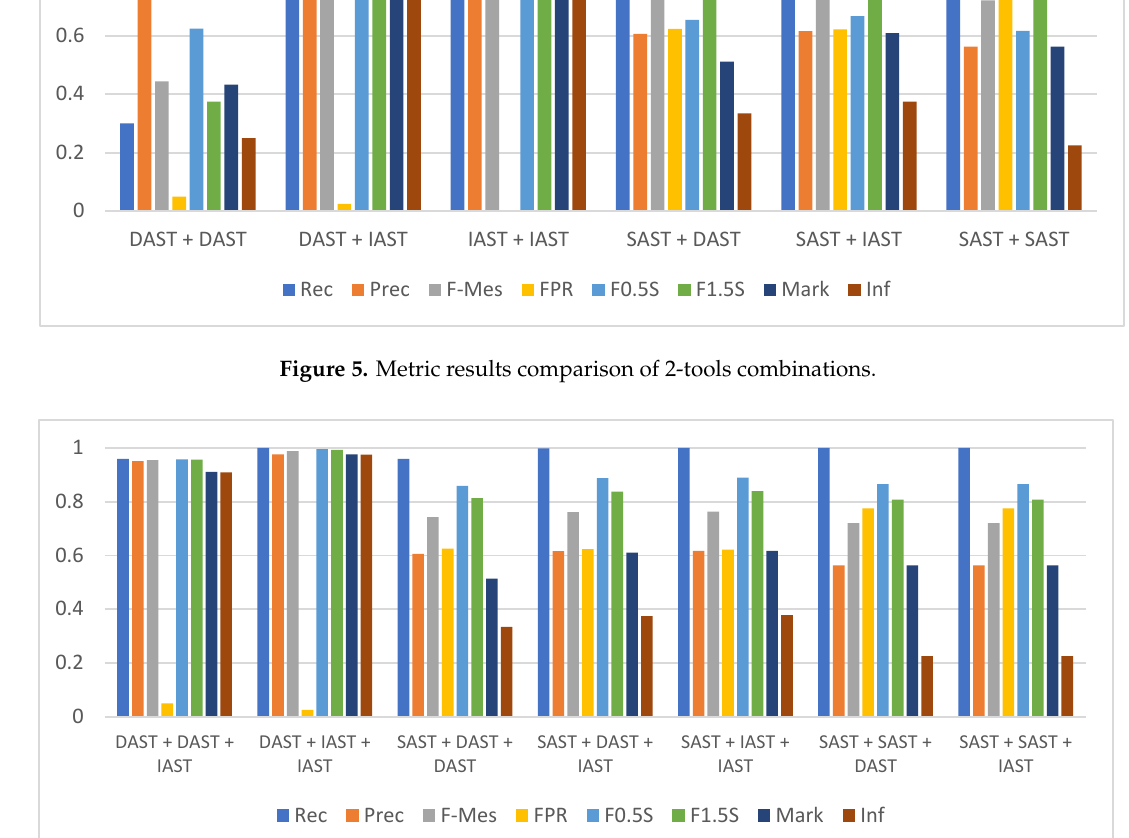
Figure 5. Metric results comparison of 2-tools combinations.